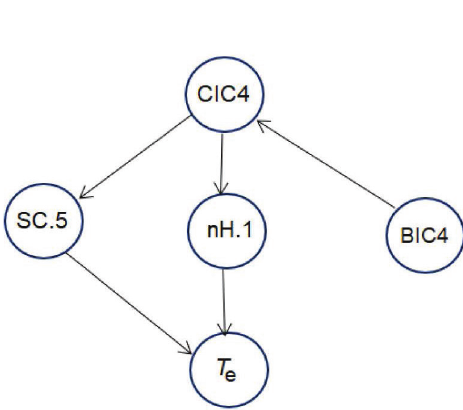
Fig. 1 – Structural model of the causal dependence of eutectic temperature on the molecular descriptors (SCM-MD)